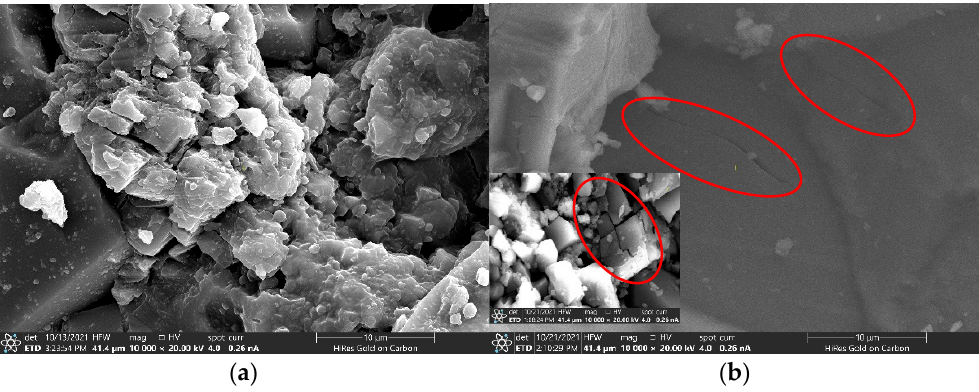
Figure 19. Diagrams of experimental data for the sample 2/46 versus dynamic load frequency f depending on the strain amplitude ε a in logarithmic coordinates: ( a ) dynamic modulus of elasticity; ( b ) real part of the modulus of elasticity; ( c ) imaginary part of the complex elastic modulus; ( d ) phase shift angle ϕ E .